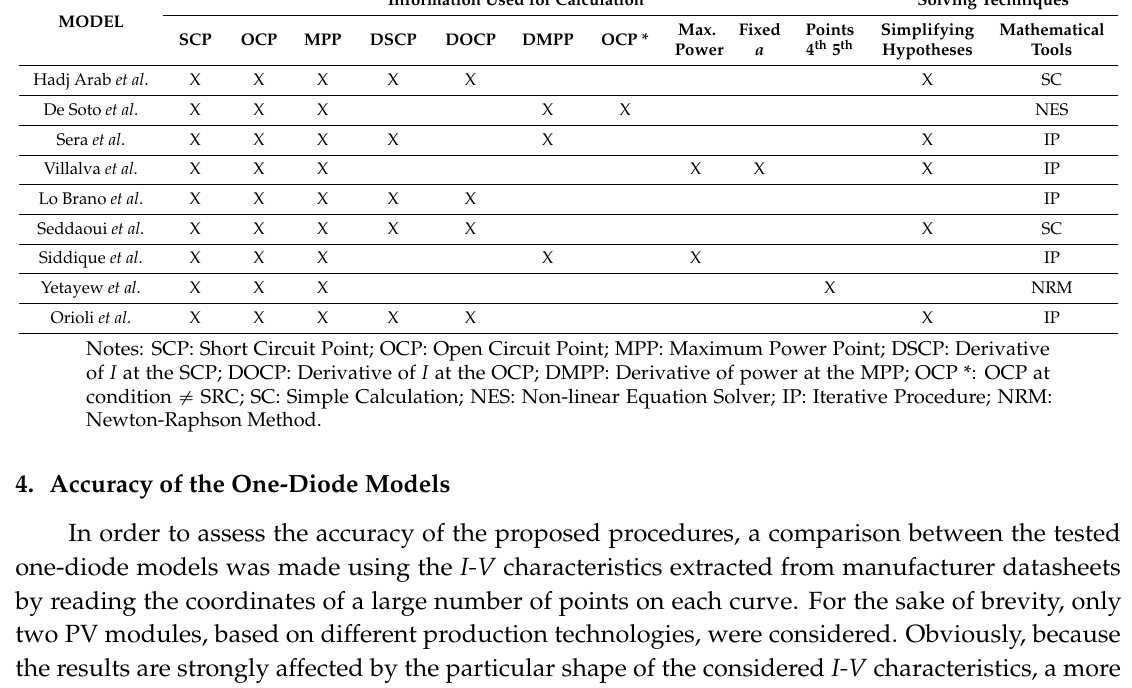
Table 1. Summary of the information and solving techniques used by the one-diode models. MODEL